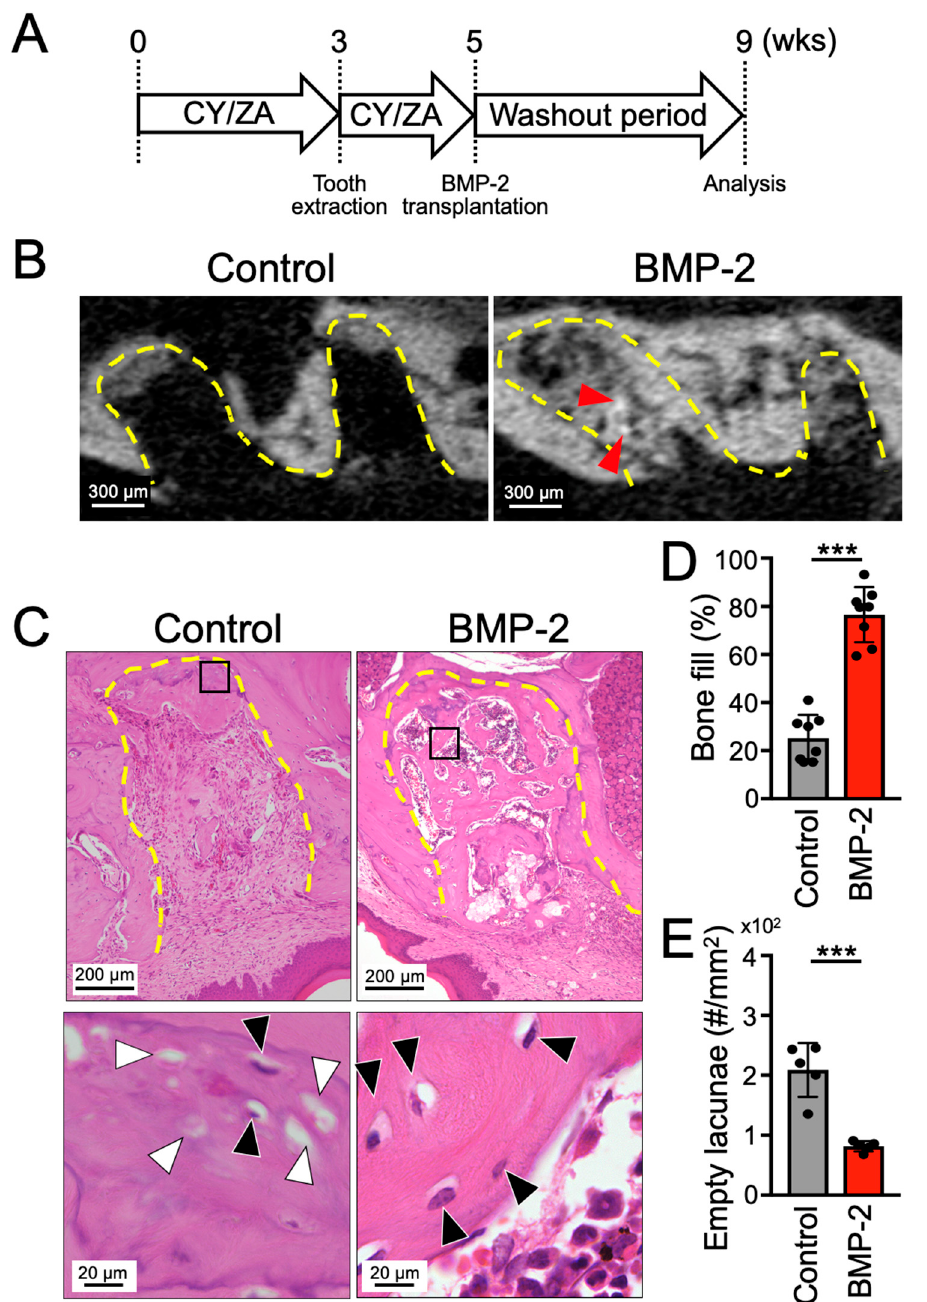
Figure 3. Transplantation of BMP-2/ β -TCP strongly induced bone formation in the tooth extraction socket in an MRONJ-like treatment model. ( A ) Experimental design. The maxillary first molar of mice was extracted after 3 weeks of CY/ZA administration in mice. Two weeks after tooth extraction, BMP-2/ β -TCP was transplanted into the tooth extraction socket under the cessation of CY/ZA administration. ZA: zoledronate, CY: cyclophosphamide. ( B ) Sagittal image of micro-CT and ( C ) HE-stained sections, 4 weeks after transplantation. Lower panels are high magnification images of the squares in the upper HE-stained images. ( D ) The bone-fill rate in the tooth extraction socket and ( E ) number of empty lacunae in regenerated bone are shown in graphs, respectively. Bars represent the mean values and standard deviation (+/ − SD) ( n = 5–8). (*** p < 0.001. Student’s t -test). Red arrowheads indicate the residual β -TCP. Black and white arrowheads indicate the osteocyte and empty lacunae, respectively. Yellow dashed lines indicate the tooth extraction socket.